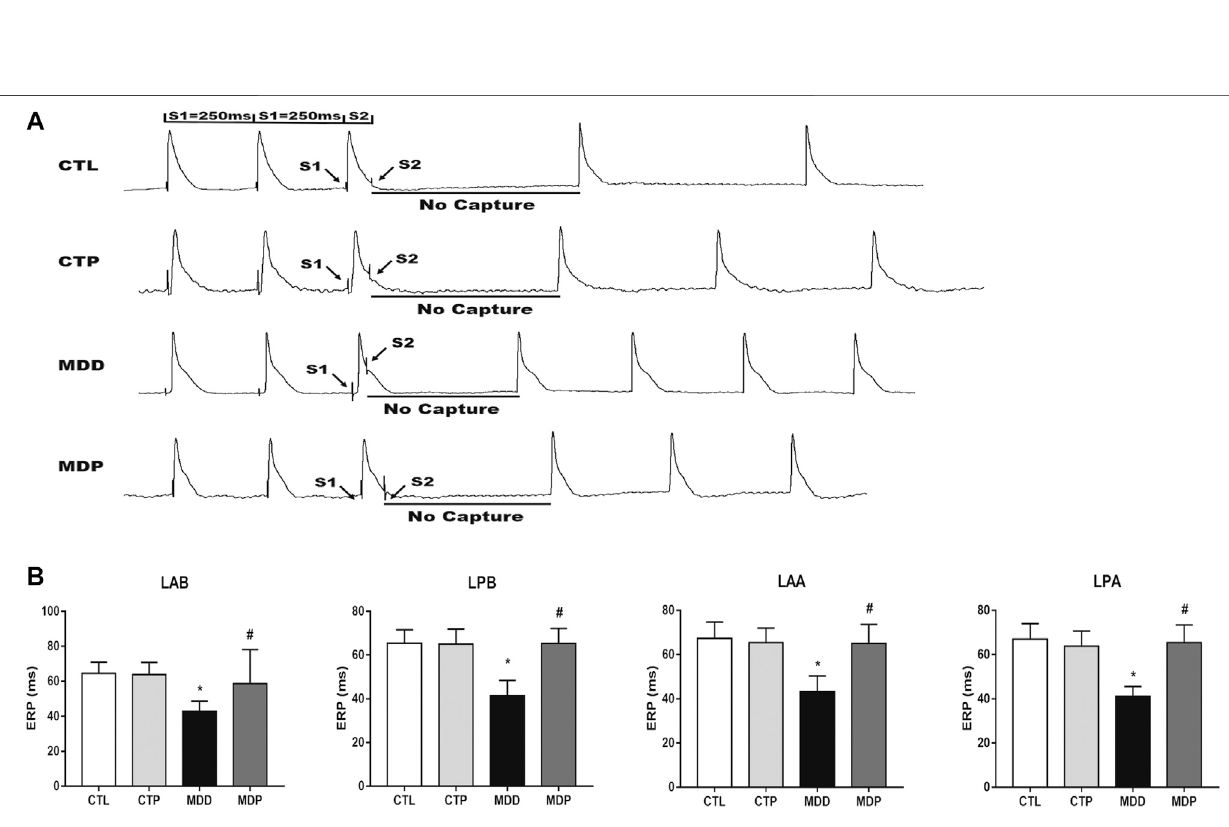
Frontiers in Pharmacology |